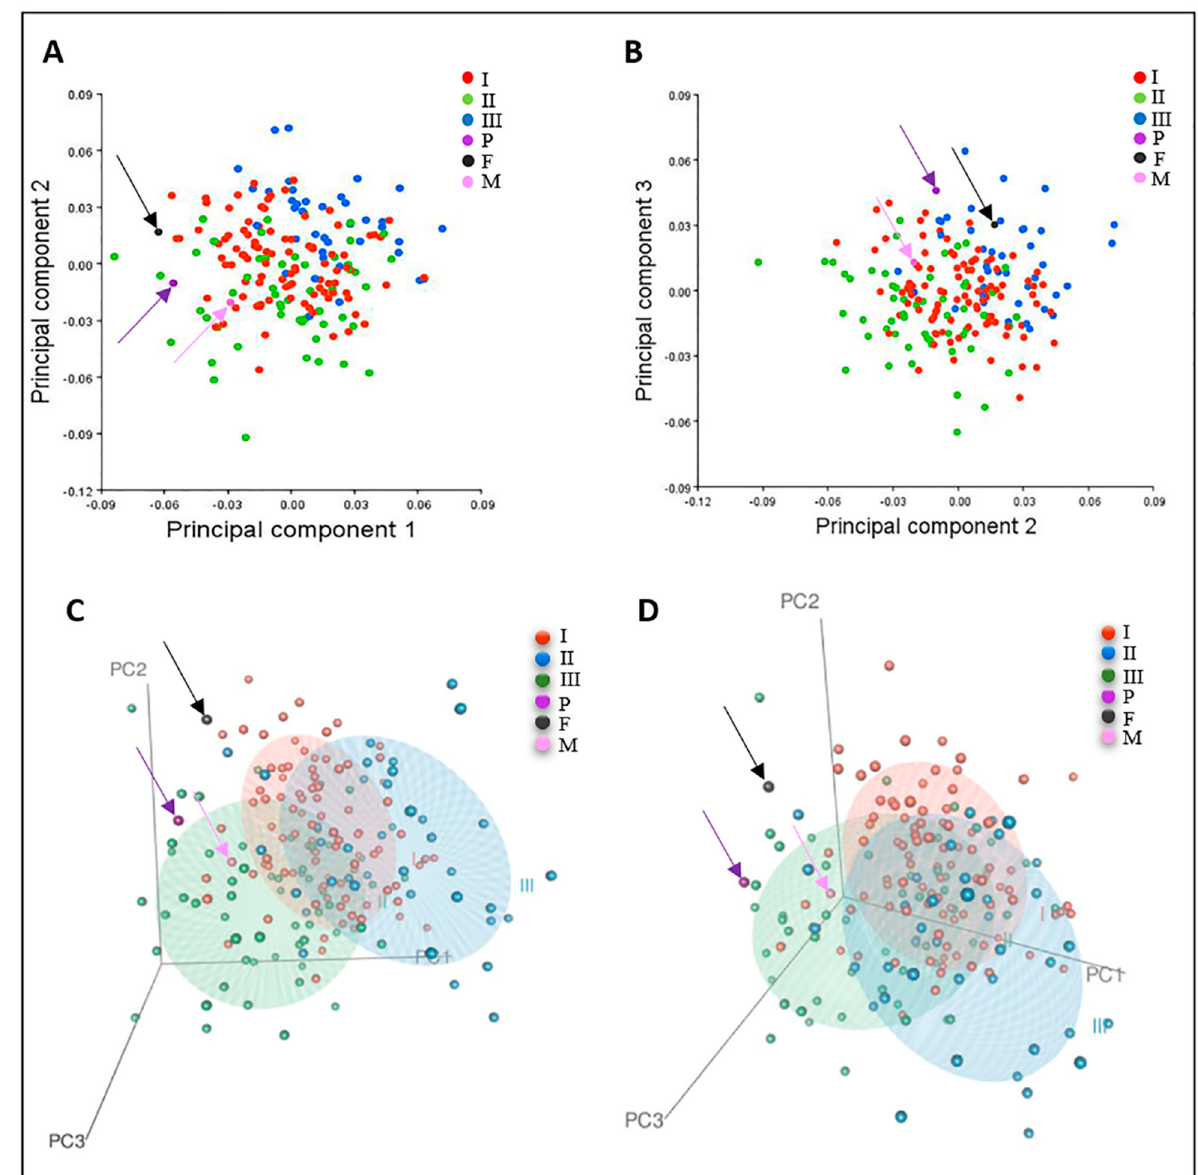
Figure 4. Visualization of the results of the principal component analysis (PCA). ( A ) Two-dimensional (2D) plot of the first two PC axes demonstrating the clustering of healthy subjects grouped into Class I, II and III, as well as the proband’s, the mother’s, and the father’s relative position. ( B ) Two-dimensional plot of the second and third axes of the same PCA plot. ( C , D ) Two different views of a three-dimensional (3D) plot of the PCA analysis including the first three PC axes and depicting the positions of the proband (P), the mother (M), and the father (F) relative to Class I, II, and III healthy subjects’ ellipsoids (I = Class I, II = Class II, III = Class III).